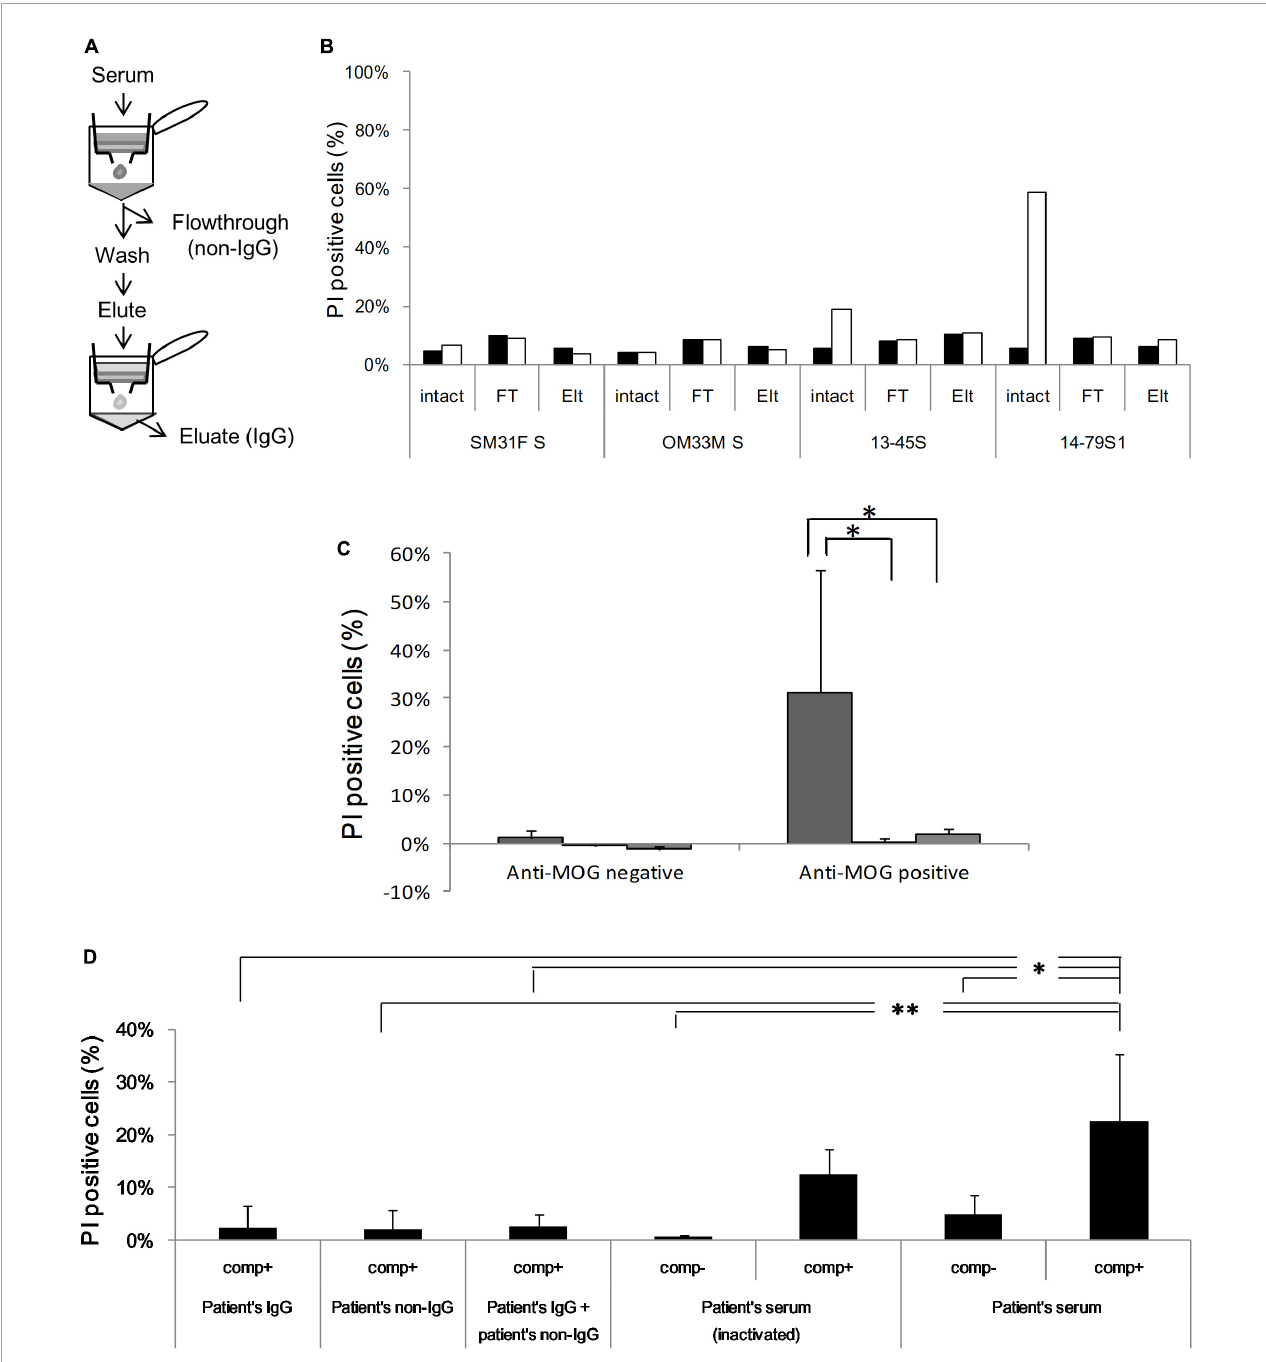
FIGURE4 (A) Serum is fractionated into IgG [eluate (Elt)] and non-IgG [flowthrough (FT)] using protein G, and anti-MOG antibody activity is assessed in each fraction by flow cytometry. (B) Cytotoxicity against MOG-GFP cells is analyzed in each fraction of healthy sera (SM31F S and OM33M S) and patients’ sera (13–45S, 14–79S1, 14–79S2, and 14–87S). Closed bar; empty cell, open bar; MOG-GFP cells. (C) Cytotoxicity in each fraction of anti-MOG-negative ( n = 2) or anti-MOG-positive ( n = 4) samples. The statistical difference of each fraction to total serum was determined by Student’s t -test ( ∗ P < 0.05). Left bar; total serum, middle bar; flowthrough, right bar; eluate. (D) Various combinations of patients’ serum fractions and rabbit complement were tested by cytotoxicity assay. The same examinations are performed three times, and the mean data is shown. Statistical analysis was performed